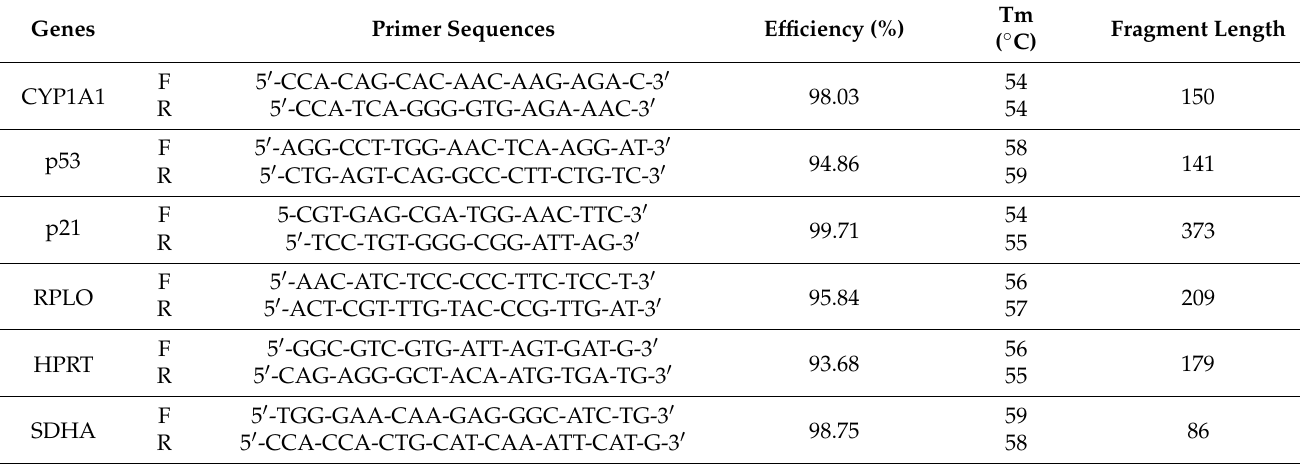
Table 1. Characteristics of the primers